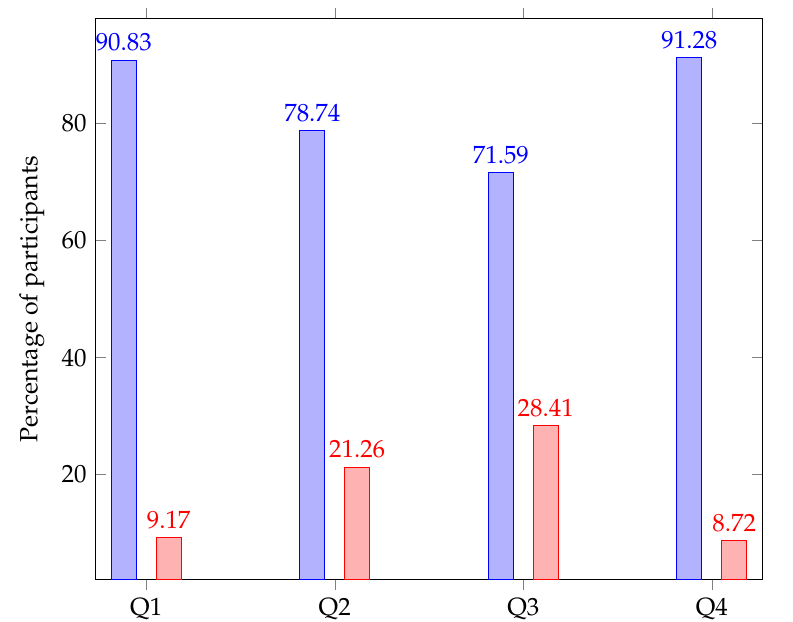
Figure 1. This figure shows the results of students’ understanding and perceptions of cheating on coursework. Q1–Q4 represent Questions 1–4 in Table 1. The blue bars represent the percentage of students who understood the definition of cheating in the relevant coursework, university regulations, and teacher requirements for noncheating on assignments, respectively, while the red bars represent the percentage of students who did not understand or agree with the items in